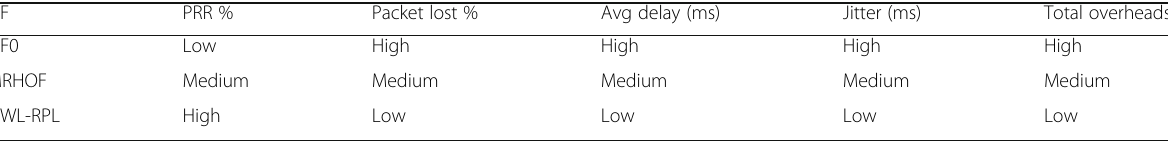
Table 11 Proposed protocol comparison with standardized protocol OF PRR % Packet lost % Avg delay (ms) OF0